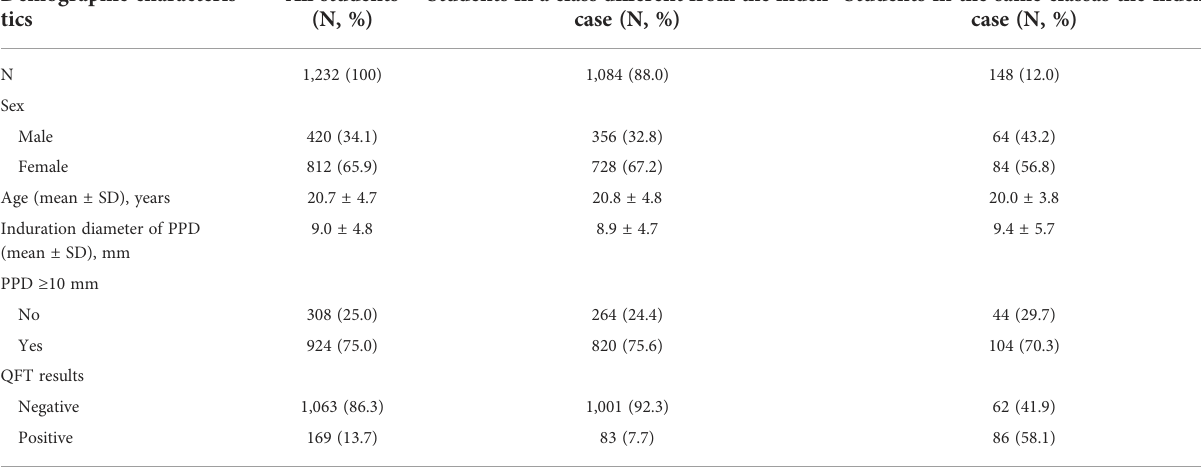
TABLE 1 Demographic characteristics of the 1,232 participants overall and those sharing the same class with the index case. Demographic characteris- tics